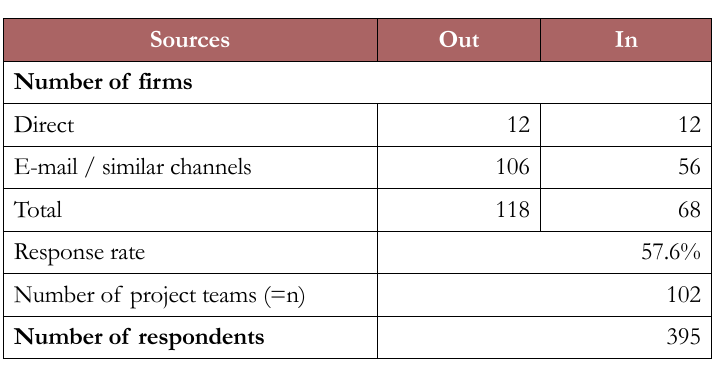
Table 2. Response